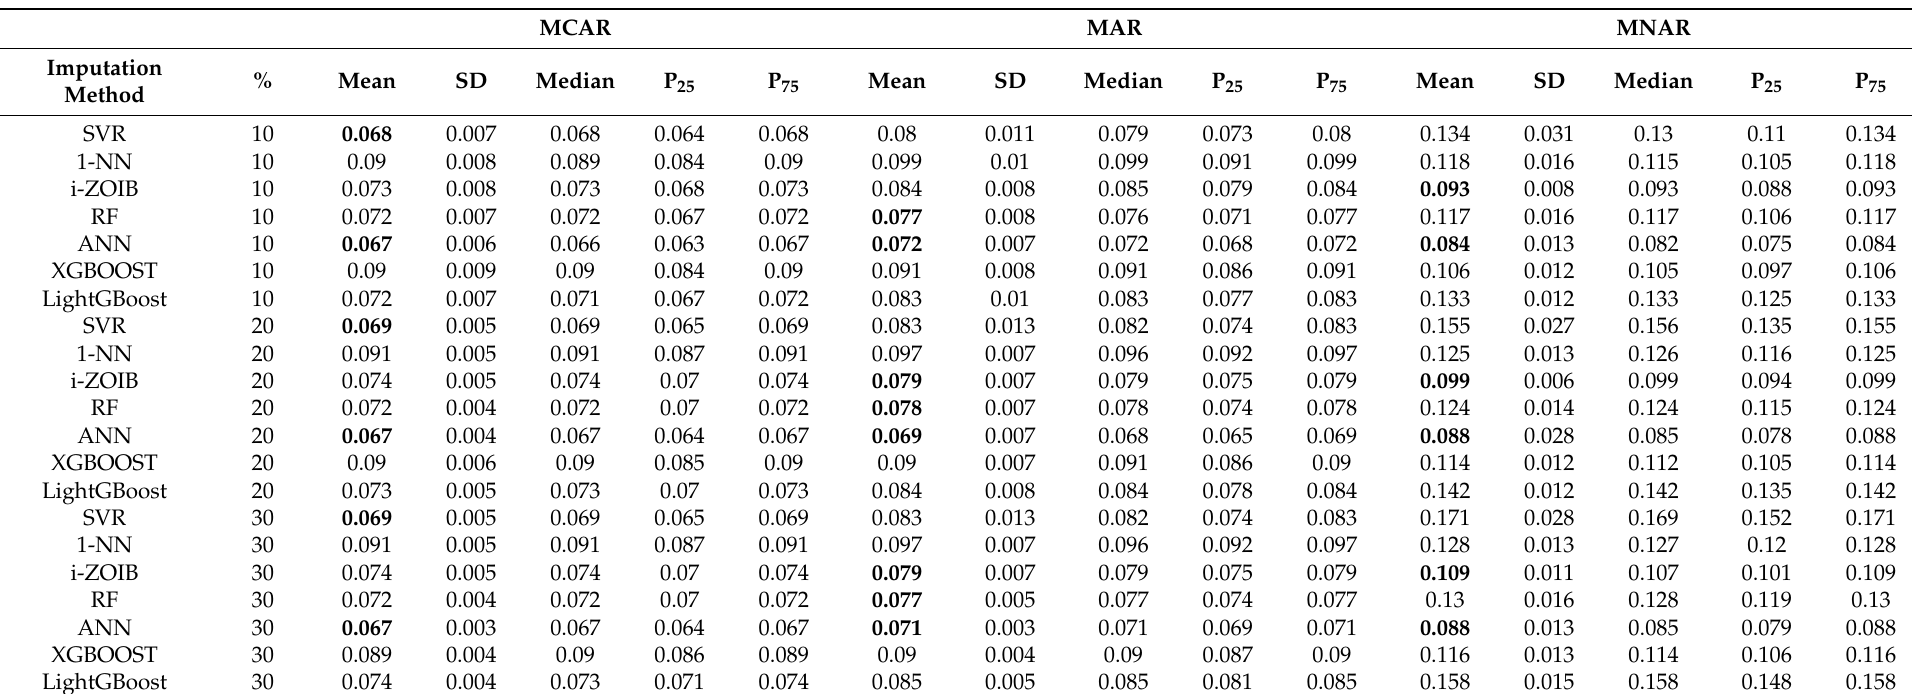
Table A2. Summary statistics of the RMSE accuracy measure according to the missingness mechanisms, rates and imputation methods in the Scenario 1. MCAR MAR